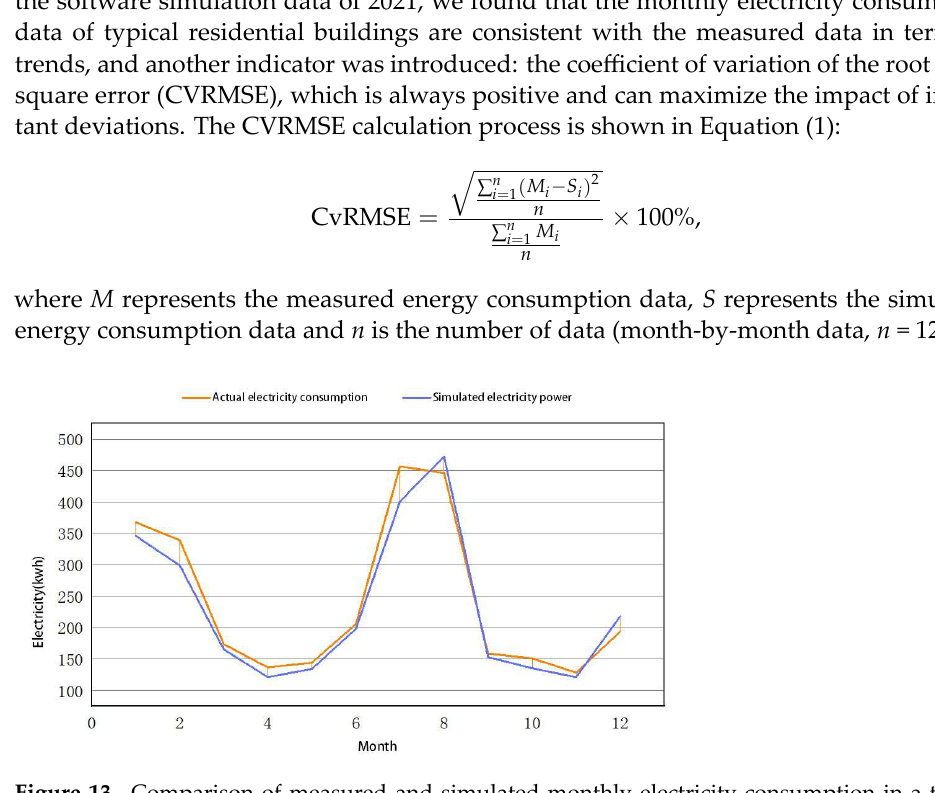
Figure 13. Comparison of measured and simulated monthly electricity consumption in a typical residential home.